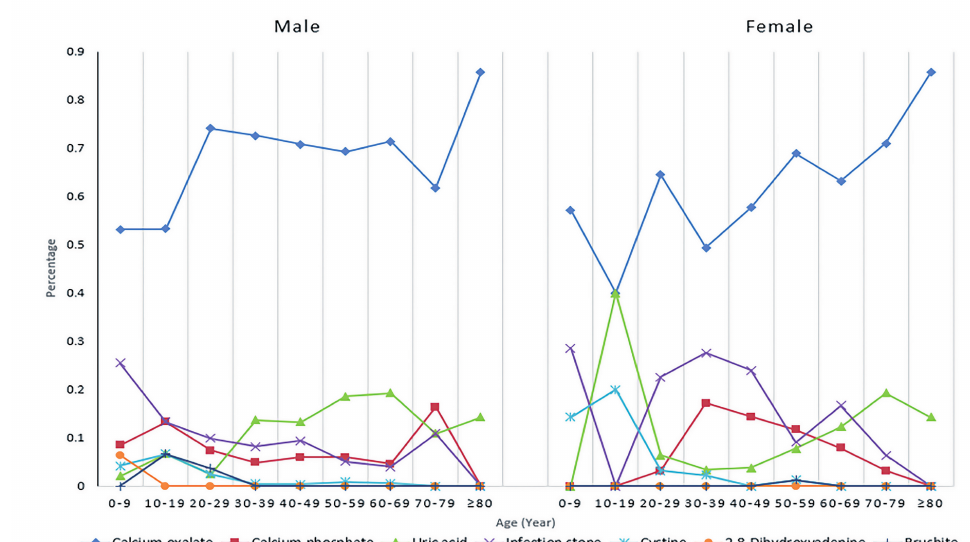
Figure 1 - Proportions of stone compositions in different age groups and